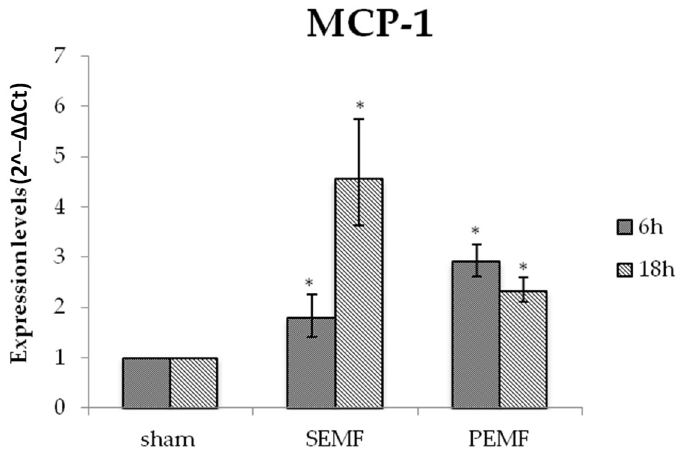
Figure 5. The mRNA expression of monocyte chemoattractant protein 1 (MCP-1) in hGFs exposed to the SEMF and the PEMF compared to sham-exposed cells. MCP-1 expression levels (2 −ΔΔ C t ) are reported as mean ± standard error (SE). * p -Value < 0.05 SEMF or PEMF vs. sham assumed as 1.